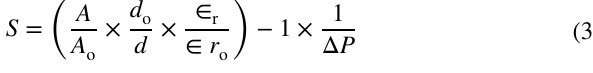
Figure 7a proposes the operation mechanism of pres- sure-sensing for pseudocapacitive iontronic PPy-CNT@ rGO// PPy-CNT@rGO microsensor. With the initial input voltage, the positive and negative charges are consistently disseminated at both ends of interdigitated PPy-CNT@ rGO//PPy-CNT@rGO electrode, respectively. Owing to the admirable capability of pseudocapacitive combina- tion electric double-layer capacitance of PPy-CNT@rGO electrode, the positive and negative electrolyte ions are evenly distributed at the interface between electrolyte and PPy-CNT@rGO active material. Hence, the neighboring interspace electrode and PVA/PSA gel electrolyte develop a microsupercapacitor unit Ci, the PPy-CNT@rGO//